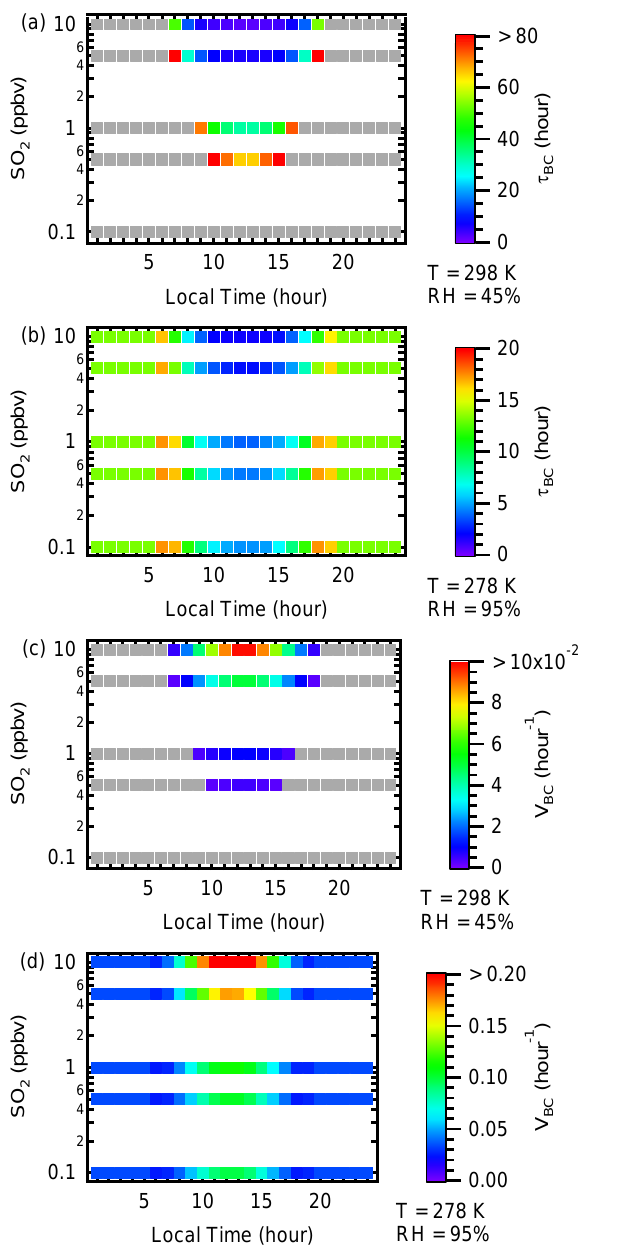
Fig. 4. Temporal variations of (a) τ BC and (c) corresponding V BC for T of 298K and RH of 45% and (b) τ BC and (d) correspond- ing V BC for T of 278K and RH of 95% as a function of the ini- tial SO 2 concentration for a given initial BC mass concentration of 1.0µgm − 3 , NO x mixing ratio of 1.0ppbv, and NH 3 mixing ratio of 1.0ppbv for the lognormal BC size distribution with a D m of 175nm and σ of 1.5. Note that τ BC values greater than 120h are indicated in gray.